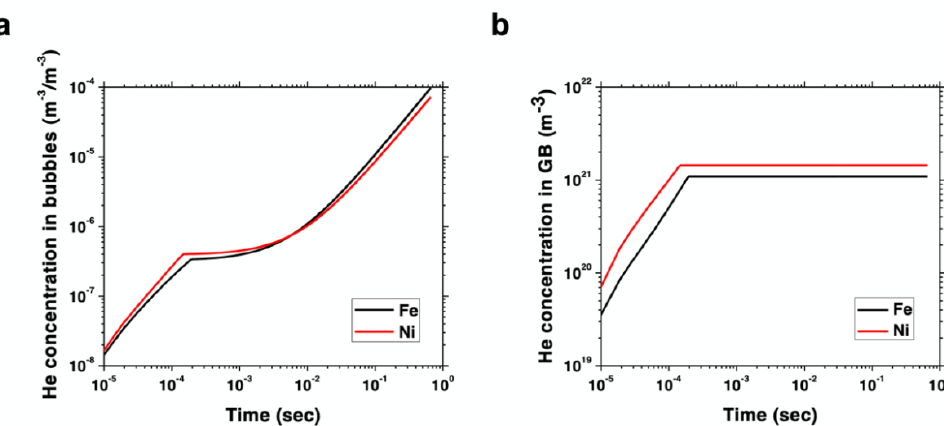
Figure 4. Rate theory model results depicting ( a ) concentration of helium (in m – 3 ) per unit bubble volume (also in m – 3 ) as a function of time during irradiation in NC Ni and Fe under the conditions of this study and ( b ) accumulation of helium atoms (in m – 3 ) at grain boundaries in Ni and Fe as a function of time.